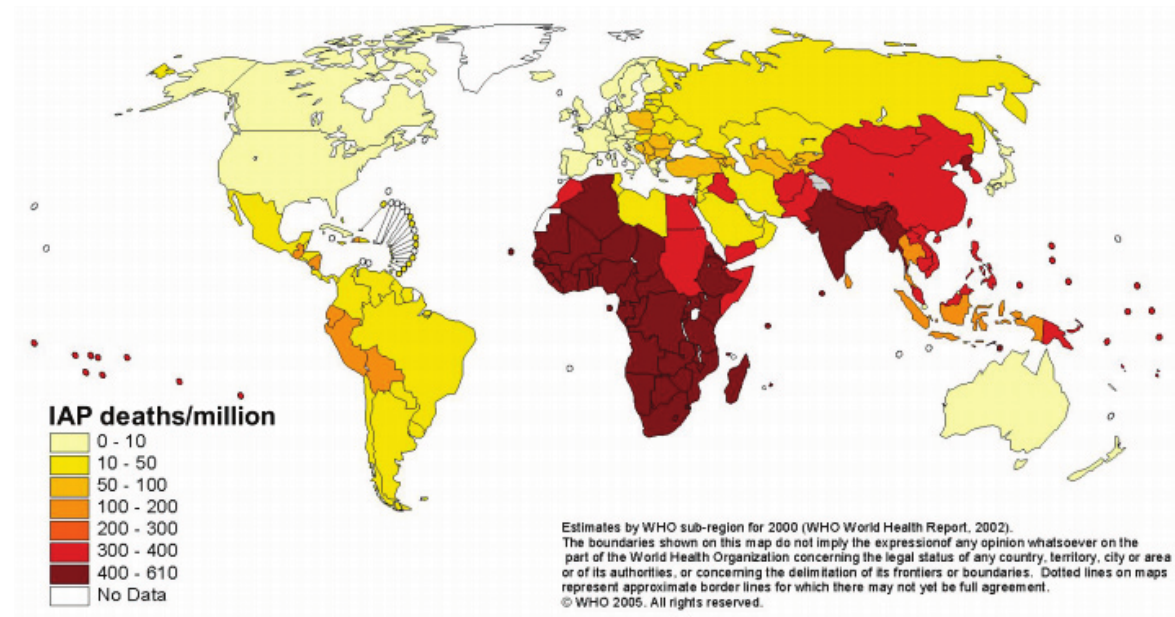
Deaths from indoor smoke from solid